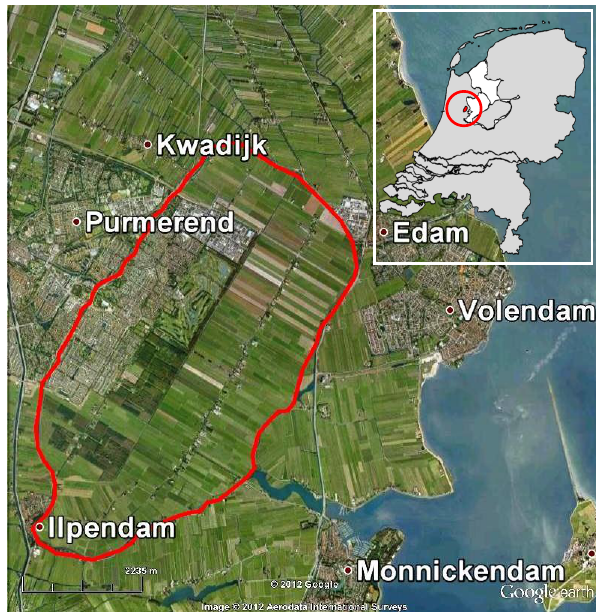
Fig. 2. Google Earth image of the measurement